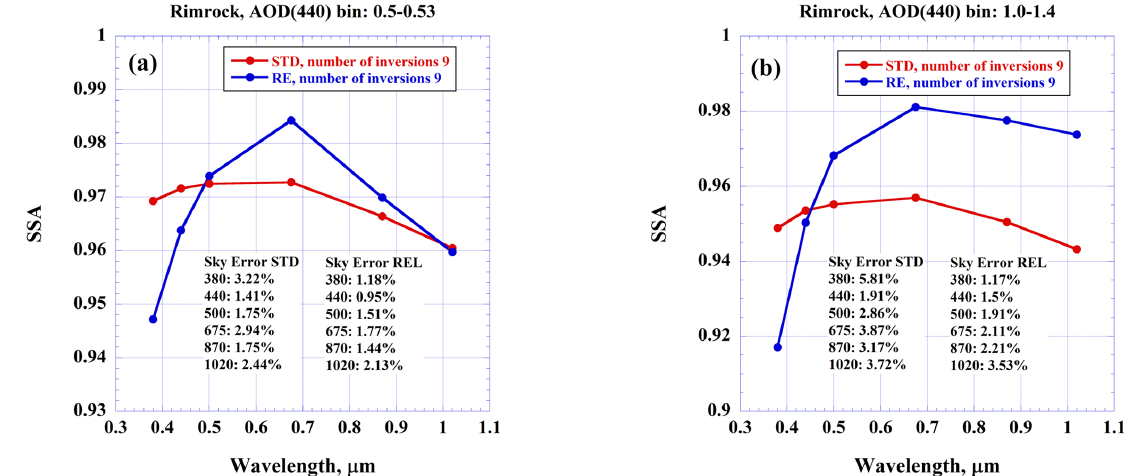
Figure 4. SSA averaged over AOD(440) bins for the Rimrock AERONET site: (a) 0.5–0.53 and (b)